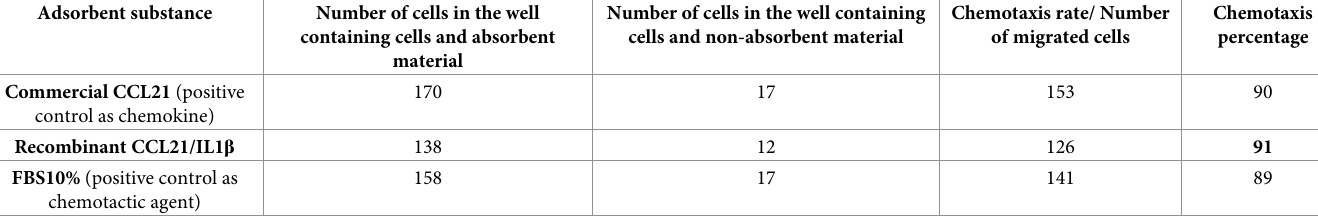
Table 2. The approximate count of migrated cells and the percentage of chemotaxis according to Fig 7A to 7D [40]. Adsorbent substance Number of cells in the well Number of cells in the well containing containing cells and absorbent cells and non-absorbent material